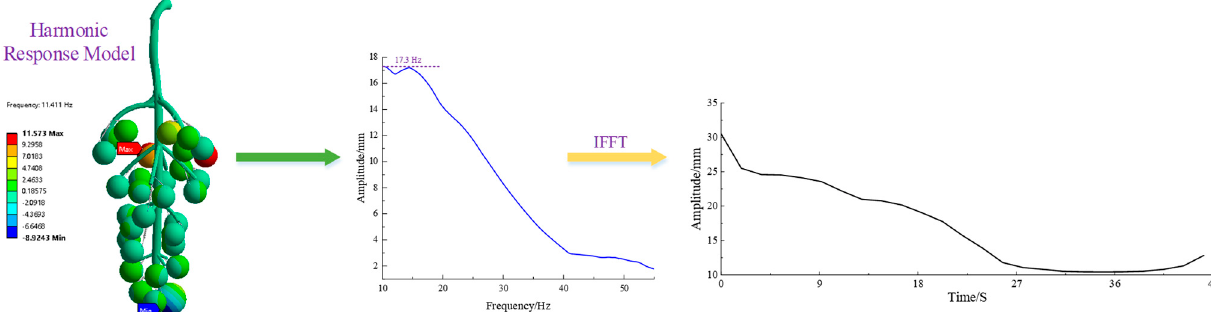
Figure 5. Grape harmonic response analysis.